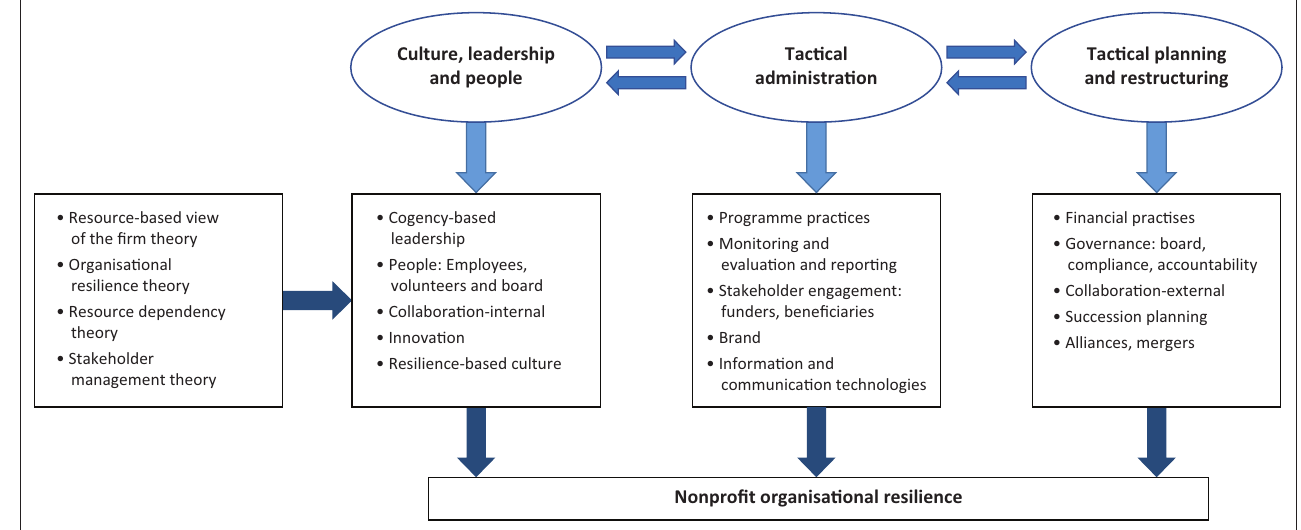
FIGURE 1: Nonprofit organisations adaptive capacities